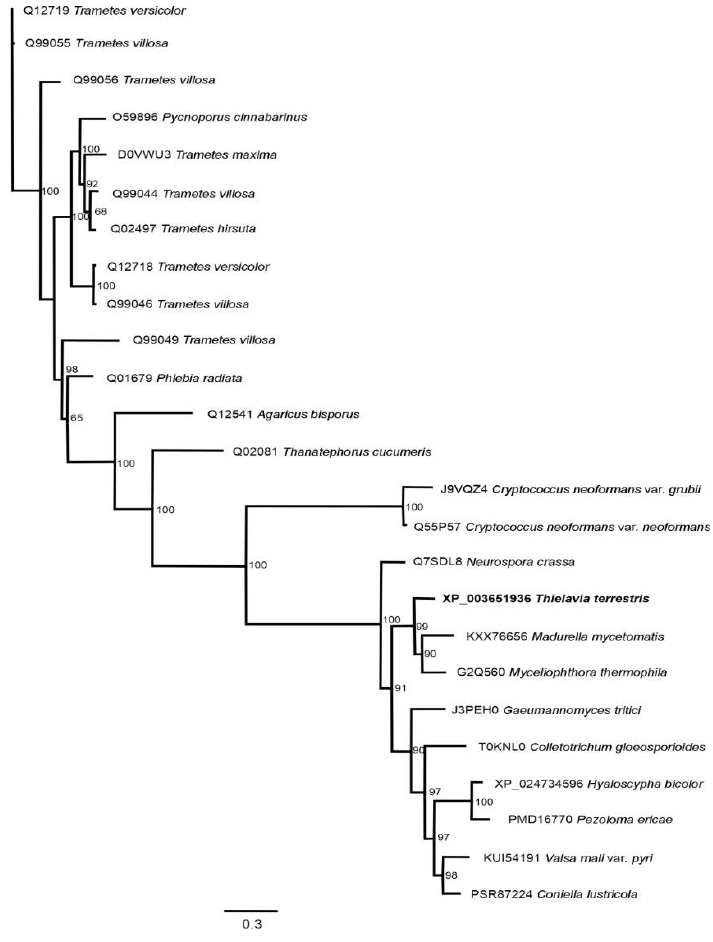
Figure 13. Maximum-likelihood tree ( 1 ) of multicopper oxidase from T. terrestris NRRL 8126 (UniProtKB: G2R0D5) with other multicopper oxidases and laccases. The analysis involved 25 amino acid sequences, accession numbers of UniProtKB, and the NCBI database; these are shown in the tree branches. T. versicolor (UniProtKB: Q12719) was used as an outgroup.